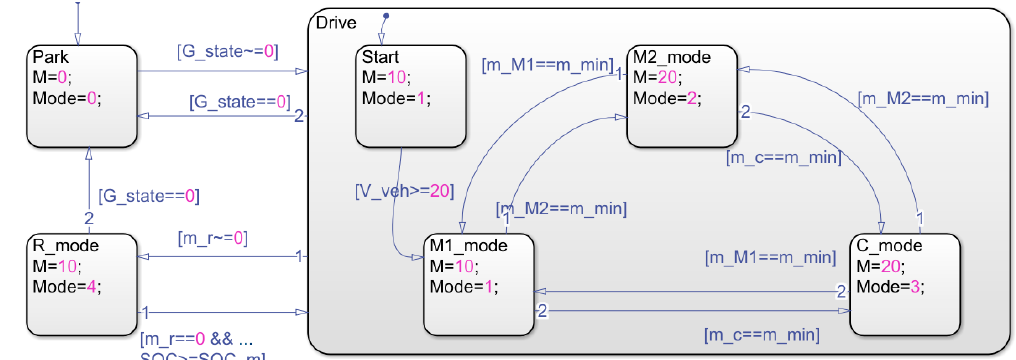
Figure 15. Stateflow chart of mode determination control.